Question: Author a descriptive caption for the visualization shown.
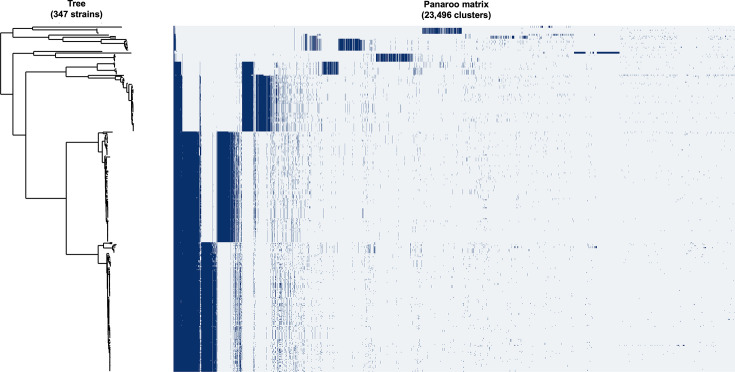
Answer: Pan-genome analysis of Weissella strains. The pan-genome matrix shows the presence or absence of 23,496 gene clusters across 347 Weissella strains, categorized into core genes (29 genes, 99%–100% present), soft core genes (40 genes, 95%–99%), shell genes (4,025 genes, 15%–95%), and cloud genes (19,402 genes, 0%–15%). The hierarchical tree on the left represents strain clustering based on genetic similarity, illustrating the high genomic diversity within the genus.